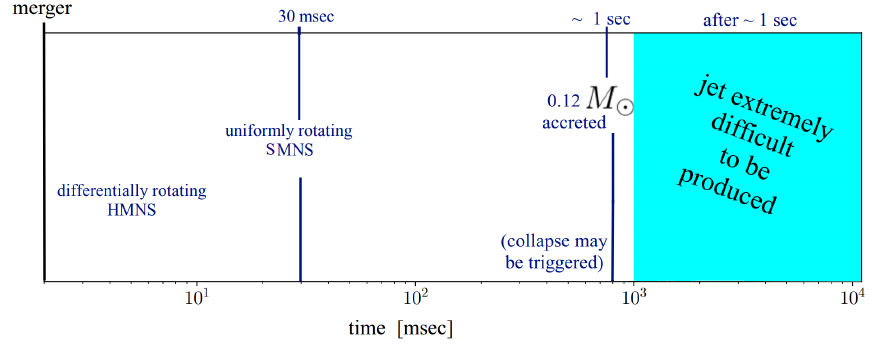
Figure 8. The lifetime of the merger remnant of mass close to the maximum for uniform rotation. The remnant does not collapse when differential rotation is lost, but collapse may be triggered when almost 0.1 M (cid:12) has been accreted. If collapse is triggered after one second, then the production of a jet may not be favoured. In this case, an explosion is triggered, releasing the enormous amounts of magnetic energy stored in the magnetosphere of the SMNS as discussed in [183]. (Reprinted from [183]. c (cid:13) AAS. Reproduced with